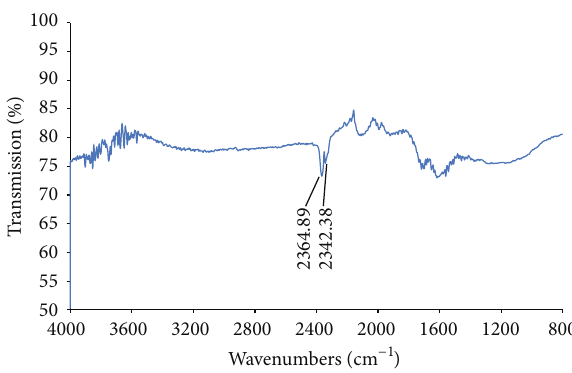
Figure 5: FTIR spectrum of the synthesized